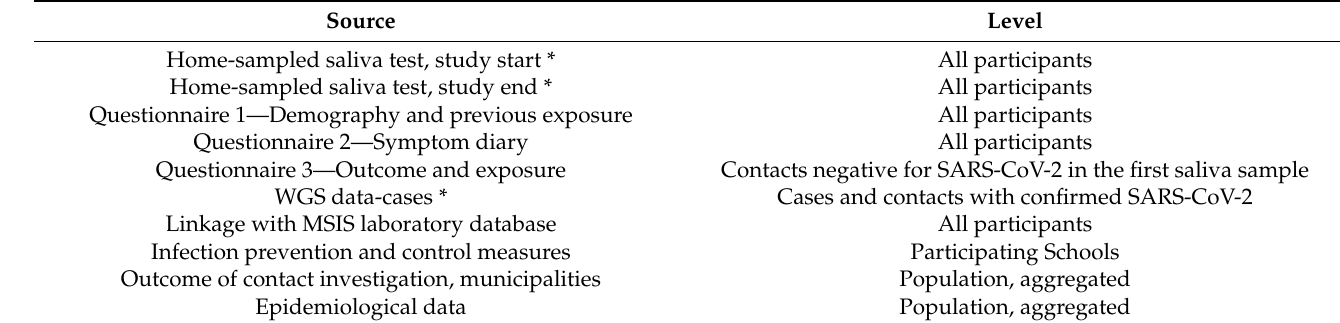
Table A1. Overview of study data and data sources.